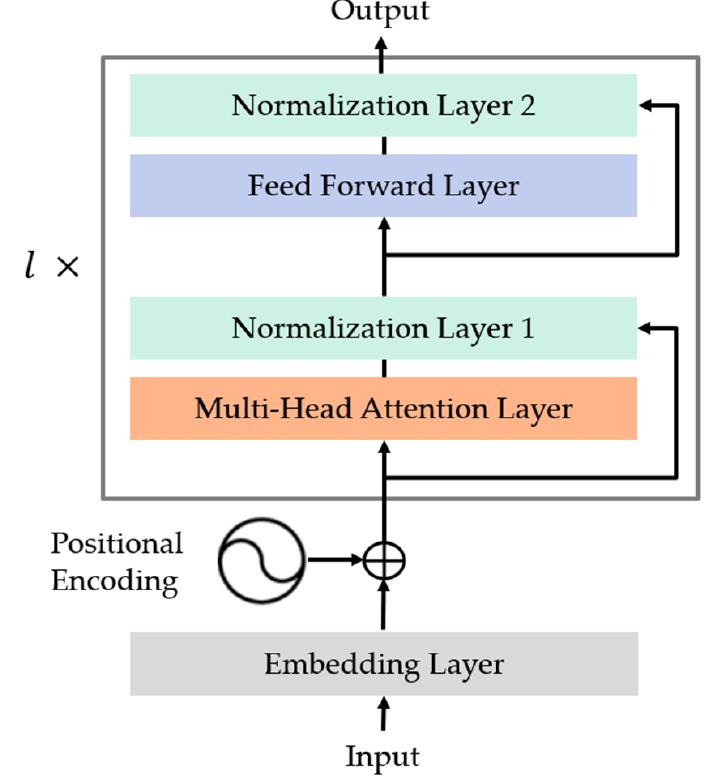
Figure 7. The architecture of RoBERTa.